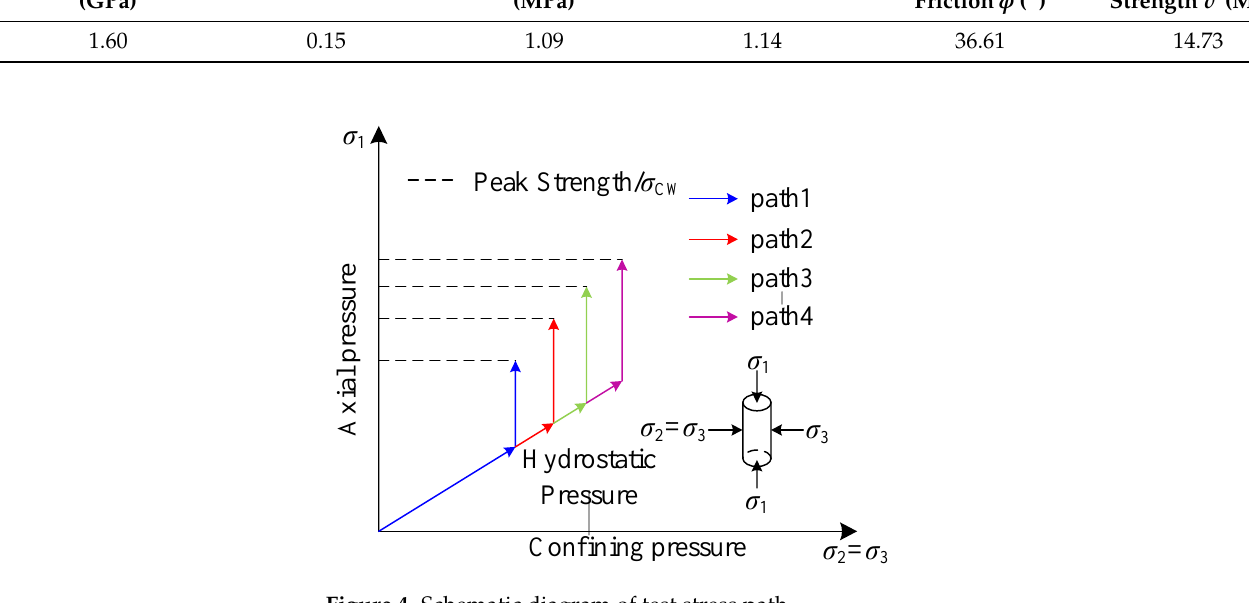
Table 1. Table of physical and mechanical parameters of test coal samples.